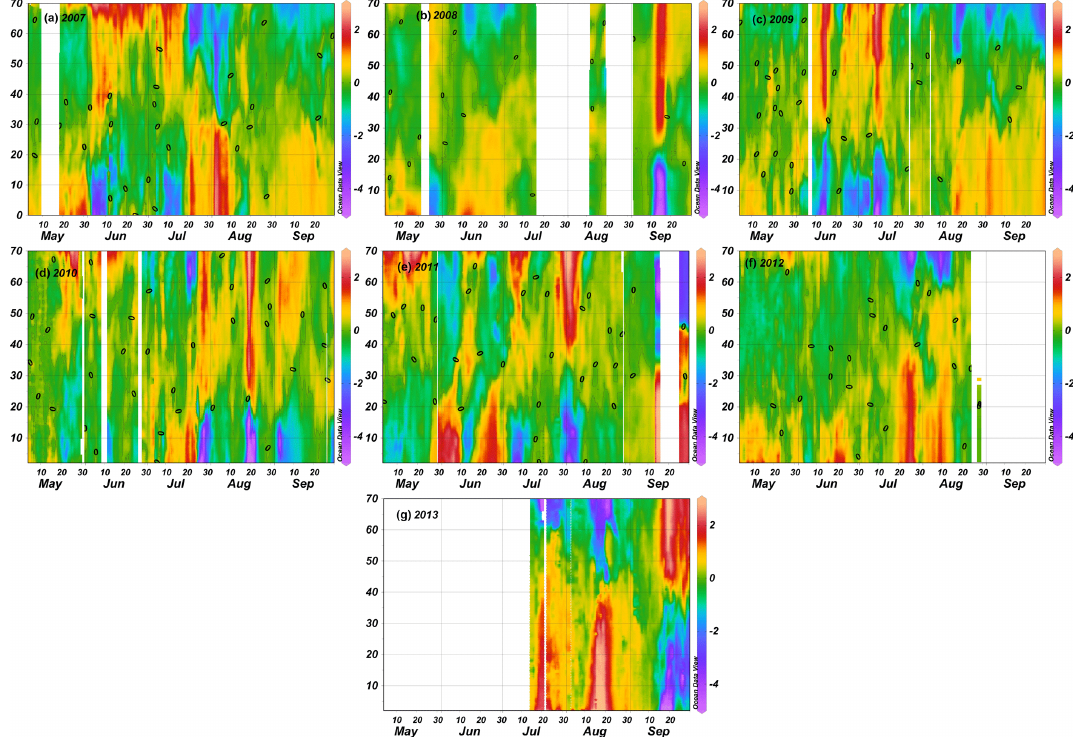
Figure 4. Temporal changes in spatial distributions of temperature deviations (in ◦ C) from the daily transect mean value between Tallinn and Helsinki from 1 May to 30 September in 2007 (a) , 2008 (b) , 2009 (c) , 2010 (e) , 2011 (f) , 2012 (g) and 2013 (h) ; y axis shows the distance from Tallinn Bay (latitude 59.48N) in kilometers along the meridional transect. Maps are made using Ocean Data View software (Schlitzer,